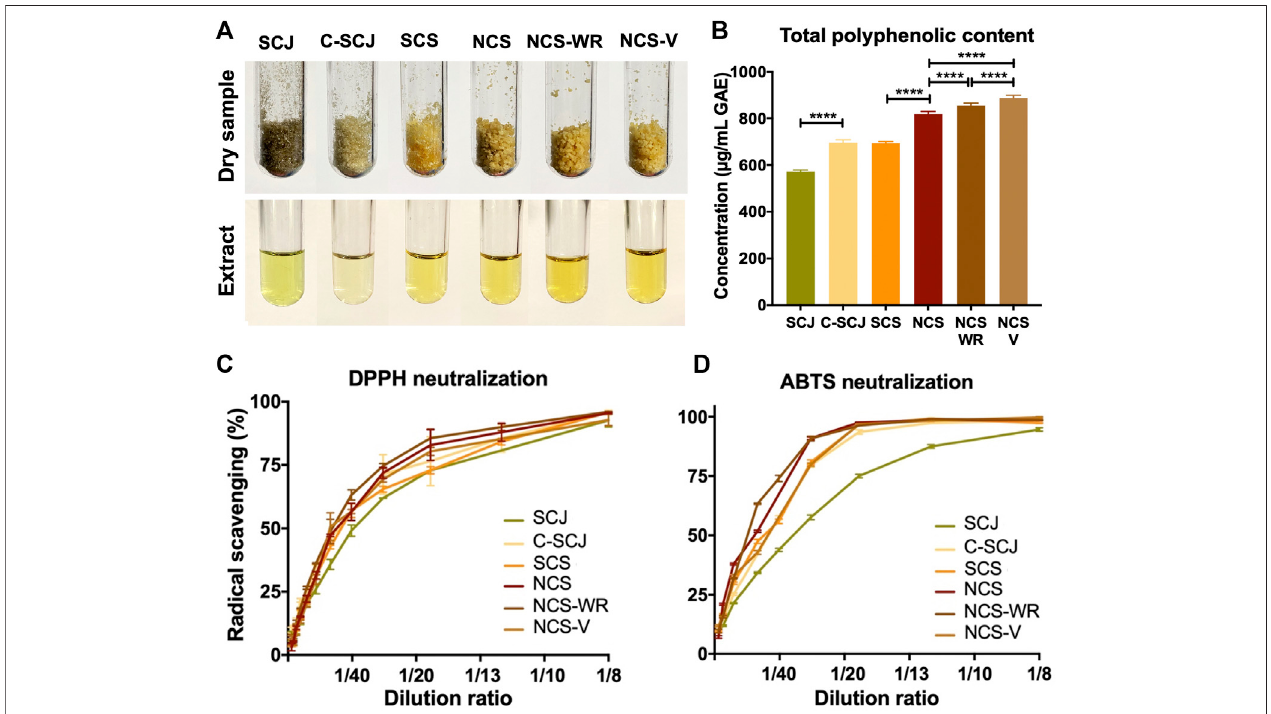
FIGURE 2 | Polyphenolic pro fi le of sugarcane-derived extracts. (A) Original dry samples and respective polyphenolic solutions after methanolic extraction. Extraction was conducted over the same dry weight for all samples and then concentrating the isolated fraction in a fi xed volume of ddH 2 O. (B) Total polyphenolic content as determined by the Folin Ciocalteu method. Total polyphenol concentration is presented as an equivalent of gallic acid (GAE). (****) denotes statistical signi fi cance p < 0.0001. (C) Radical scavenging activity of sugarcane-derived extracts in the presence of DPPH and (D) ABTS radicals. Extract dilutions were prepared from stock solutions comprising the extracted fraction of a fi xed sample dry weight reconstituted in a fi xed volume. SCJ, Sugarcane juice; C-SCJ, clari fi ed sugarcane juice; SCS, sugarcane syrup; NCS, non-centrifugal sugarcane; NCS-WR, NCS produced through window refractance evaporation; NCS-V, non-centrifugal sugarcane produced through vacuum-aided